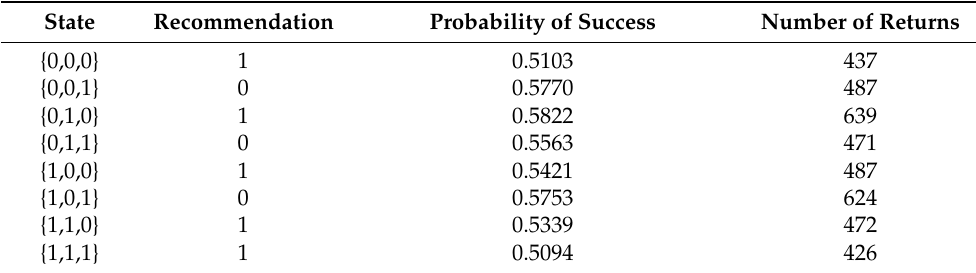
Table 2. Prediction table for the SMBR(25,3) model of the AUD/NZD. Source: